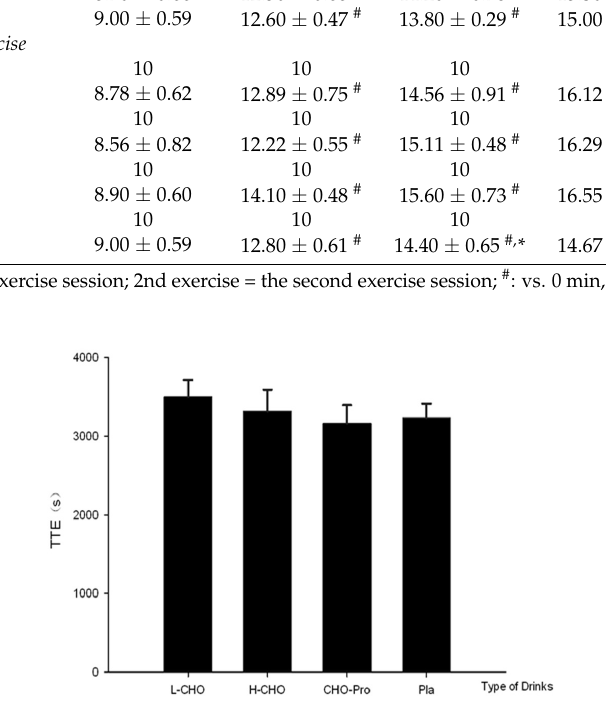
Figure 5. Time to exhaustion (TTE) following treatments.